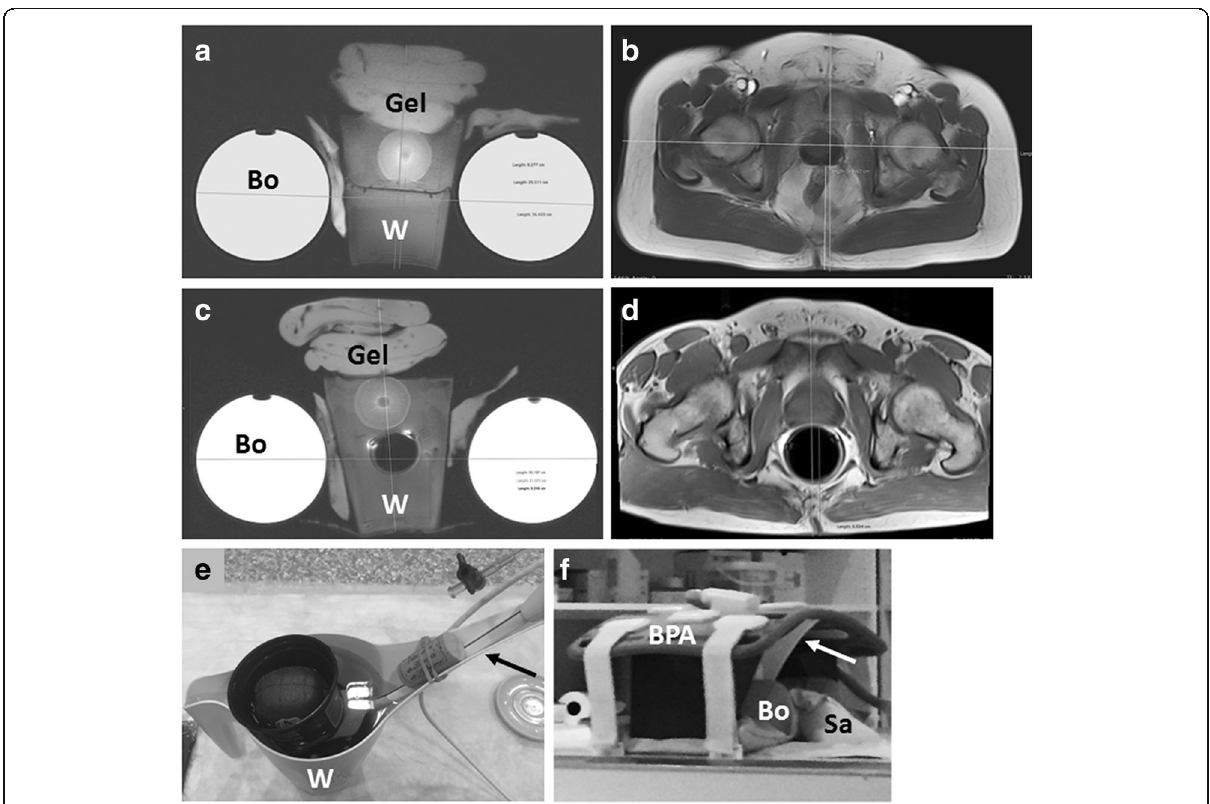
Fig. 1 Setup of kiwifruit phantom and comparison with a male human pelvis. Respective axial MR-images of kiwifruit phantom ( a , c ) and human pelvis ( b , d ) examined with bi-parametric magnetic resonance imaging at 3.0 T without ( a , b ) and with an endo-rectal coil ( c , d ) included in a multichannel phased-array coil system show similar coil-load; “ Bo ” indicates copper-sulphate solution bottle, “ Gel ” indicates gel compress-packs, and “ W ” indicates open-spout plastic watering-can. Photographs ( e , f ) show a watering can (W) with endo-rectal coil handle fixed in the spout (arrow) with a wine-cork and rubber-band, and set-up complete with supporting sandbags (Sa) and abdominal phased-array surface coil